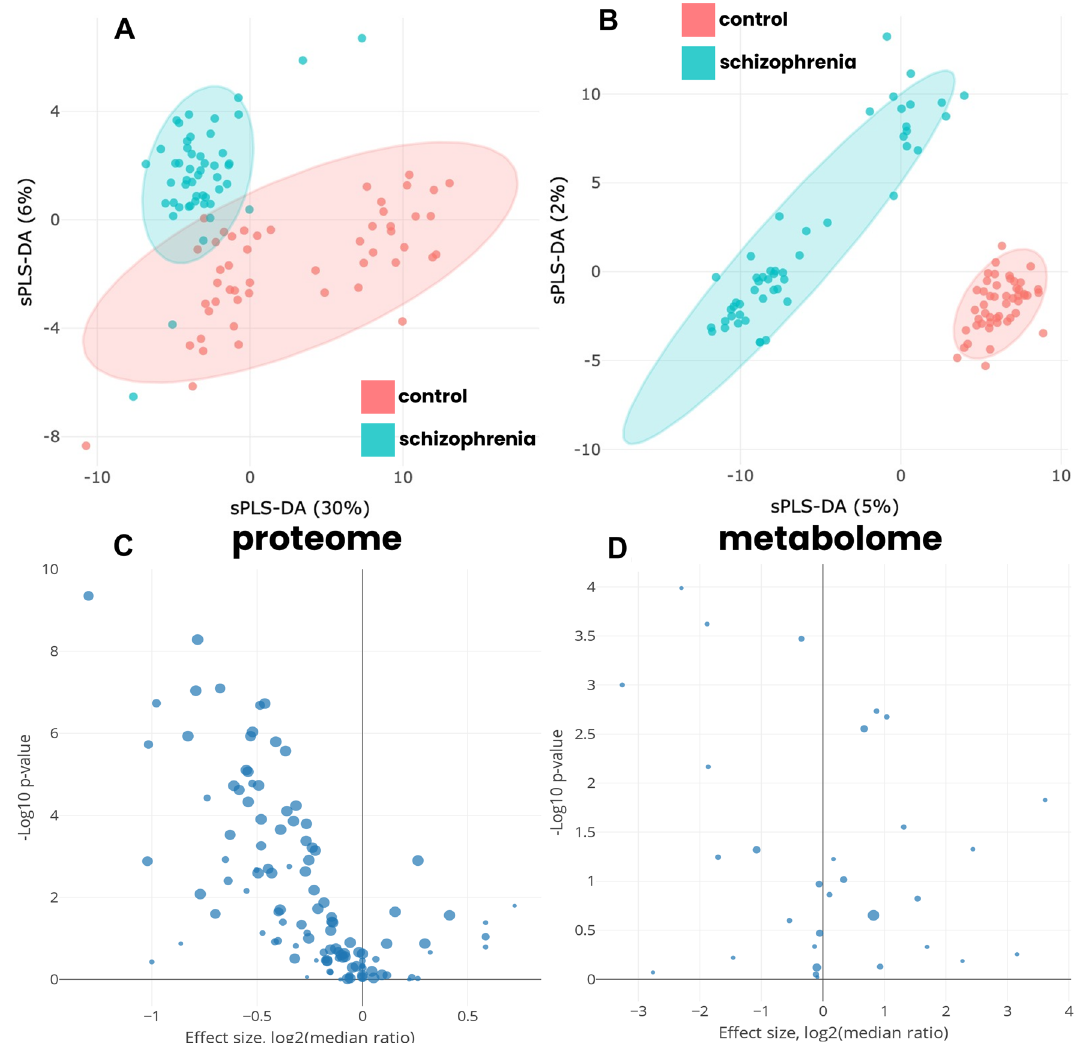
Figure 2. Discriminant analysis of studied cohorts and scatter volcano plot of the most significantly altered proteins and metabolites. Sparce partial least-squares discriminant analysis (sPLS-DA) for proteome ( A ) and metabolome ( B ) data type with 0.95 ellipse confidence level. The designed score scattering plots show relationship between the control group and patients with schizophrenia, and the degree of variations that were explained by each component consisted of PC1 = 30% and PC2 = 6% for proteomic data ( A ) and of PC1 = 5% and PC2 = 2% for metabolomic data ( B ). A volcano plot for the most significant variables determined in proteome ( C ) and in metabolome ( D ) that enabled to discriminate the control group from patients with schizophrenia (Supplementary Appendix C, Appendix D). Only proteins and metabolites with scores exceeding FC = 2 (in linear scale) and p-value above 0.05 (Mann–Whitney U-test) were considered as significant and were engaged for the reconstruction of multilayer molecular events chain. All other analyses were performed with the in-house scripts written in R (version 3.2.0; R Foundation for Statistical Computing, Vienna, Austria; https:// www.r- proje ct.